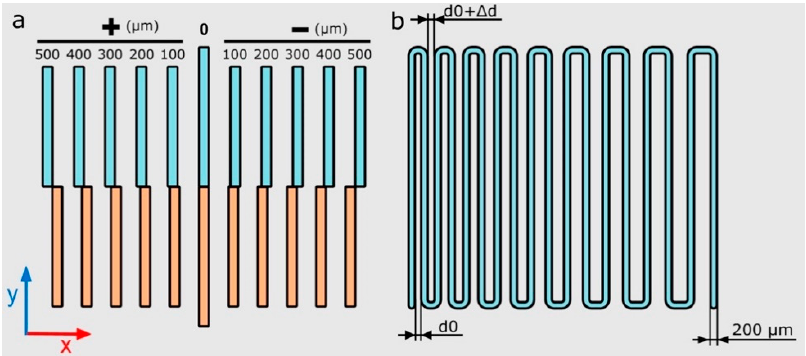
Figure 6. Schematic illustration of the calibration models xy -offset pattern ( a ) and printing pressure dependent zigzag path ( b ) where the distance d0 = 200 μ m, and the variation Δ d = 20 μ m. Both calibration models were printed using 40 wt % P407 on 50 × 75 × 1 mm glass slides (Corning Inc, New York, NY, USA). The P407 was loaded into 3 mL and 5 mL syringe barrels (Nordson EFD) at 4 °C and extruded at 24 °C. xy -offset calibration model was printed using tapered nozzles with three different inner diameters: 200 μ m (27G; Nordson EFD), 250 μ m (25G; Nordson EFD) and 330 μ m (23G; Nordson EFD). The calibration model 2 was printed in a range of pressures from 12 psi to 20 psi and speed from 5 mm s − 1 to 25 mm s − 1 using a 27G tapered nozzle.